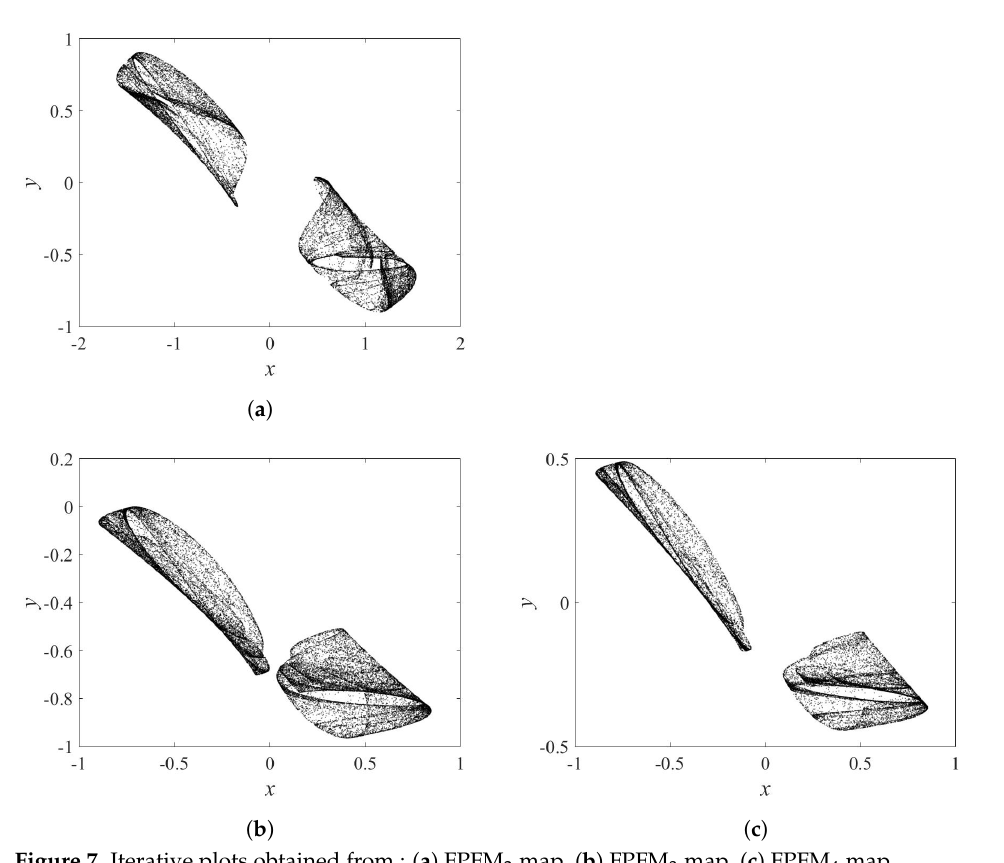
Figure 7. Iterative plots obtained from : ( a ) FPFM 2 map, ( b ) FPFM 3 map, ( c ) FPFM 4 map.